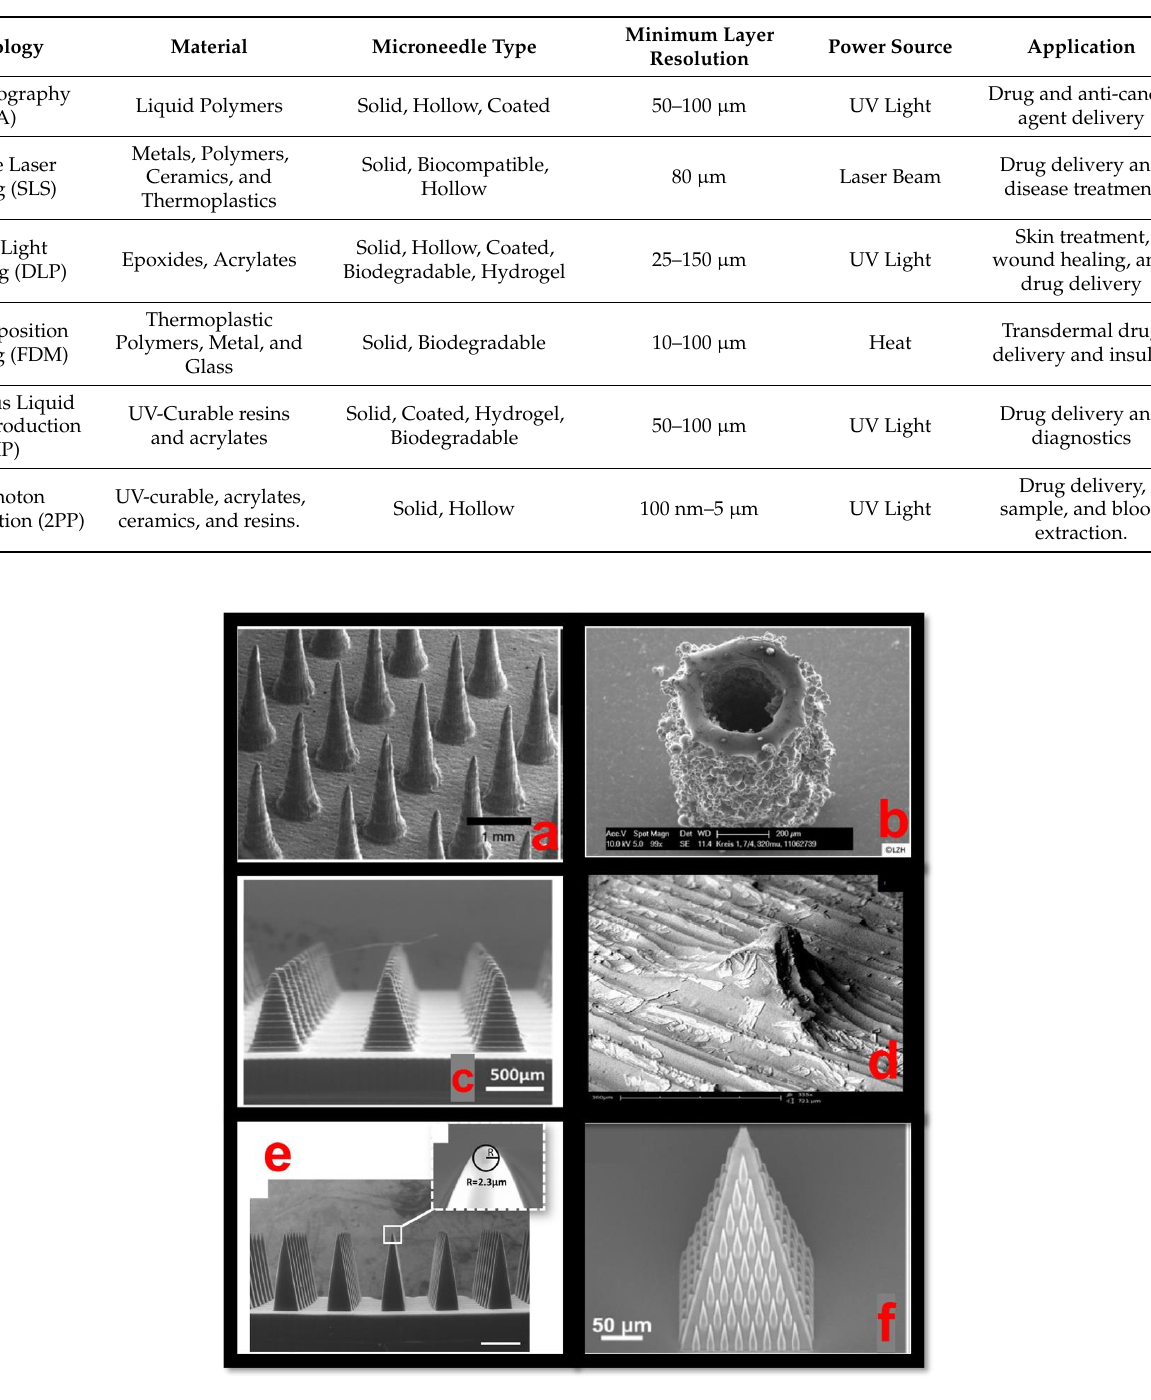
Figure 4. Scanning electron microscopy (SEM) images of microneedles (MNs): ( a ) Stereolithography (SLA) technique MNs [117], ( b ) Selective laser sintering (SLS) technique MNs [115], ( c ) Digital light processing (DLP) technique MNs [117], ( d ) Fused deposition modelling (FDM) technique MNs [118], ( e ) Continuous liquid interface production (CLIP) technique MNs [119], ( f ) Two-photon polymerization (2PP) technique MNs [117]. Table 4. Different 3D-printing technologies used for the fabrication of microneedles based on the microneedle type and application [115 – 117].